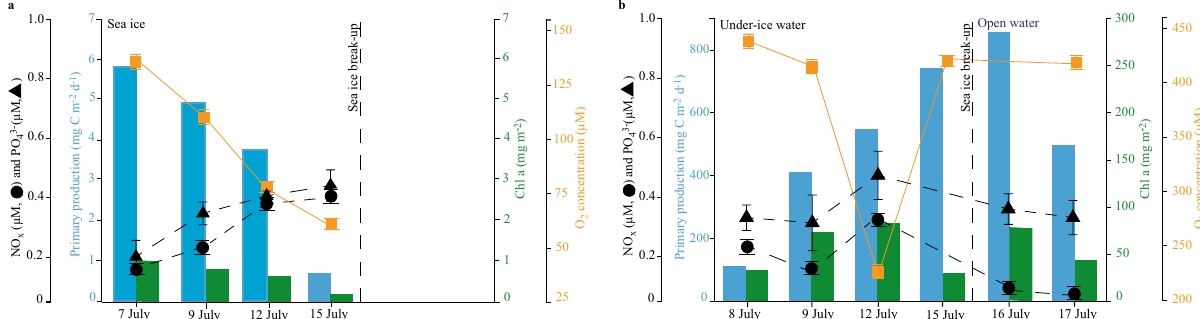
Figure 2. Comparison of sea ice and seawater biomass and productivity. Temporal development of ( a ) sea ice integrated primary production in mg C m −2 day −1 (blue bars), integrated Chl a in mg m −2 (green bars), NO x concentration in µM (black circles), PO 43- concentration in µM (black triangles) and O 2 bulk concentration in µM (orange squares) and ( b ) under-ice and open water integrated primary production in mg C m −2 day −1 (blue bars), integrated Chl a in mg m −2 (green bars), NO x concentration in µM at 1 m (black circles), PO 43- concentration in µM at 1 m (black triangles) and O 2 bulk concentration in µM at 1 m (orange squares). The data points represent the average of triplicate samples; error bars indicate SD of the